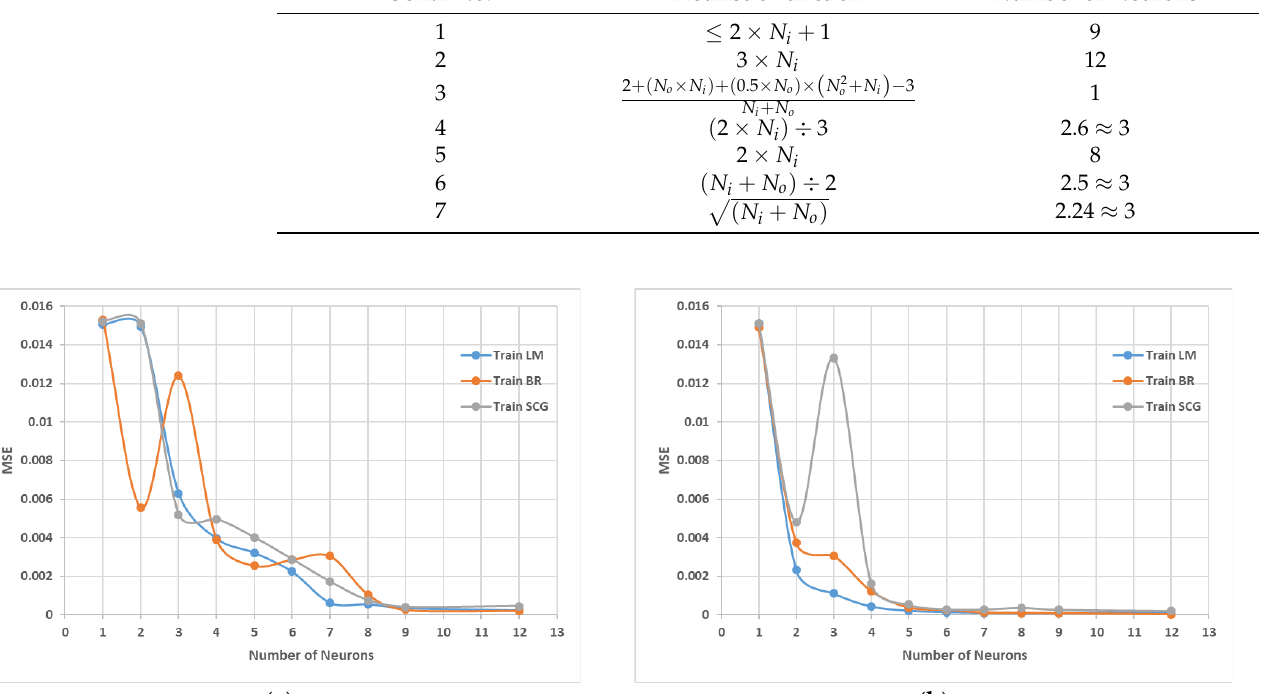
Figure 4. Comparison of 3 ANN backpropagation algorithms. ( a ) MSE of three different architectures with one hidden layer. ( b ) MSE of 3 ANN architectures with two hidden layers.